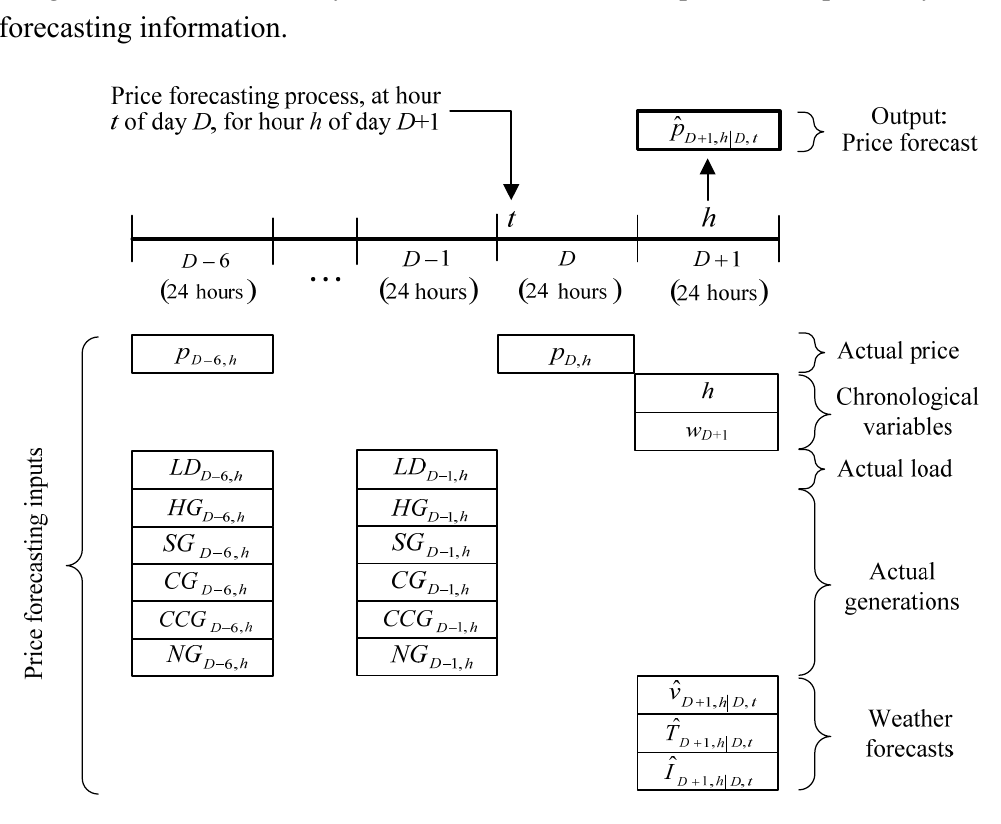
Figure 1. Time framework for price forecasts of the EMPF